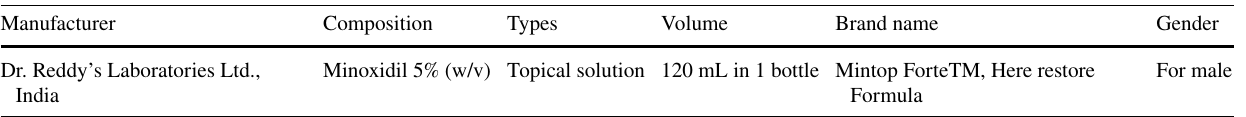
Table 11 Minoxidil topical solution USP 5%